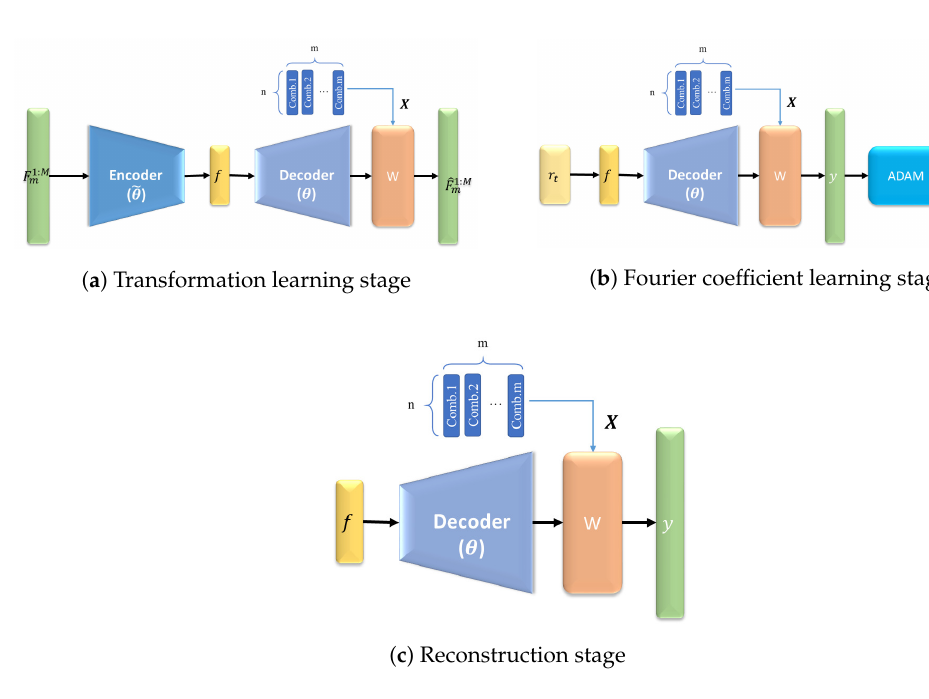
Figure 2. The illustration of the deep neural networks for submodular functions. ( a ) Transformation learning stage: In this stage, the goal is to train the decoder networks through input signal ( F 1: M m ) . The input signal F 1: M m is compressed as the Fourier coefficients ( f ) by encoder networks. Then, the f is decompressed by decoder networks. The decompressed f and combinational inputs generate the estimated signal ( ˆ F 1: M m ) . ( b ) Fourier coefficient learning stage: In this stage, the goal is to train the Fourier coefficients ( f ). The Fourier coefficients ( r t ) at time t are decompressed by the decoder networks. The decompressed f and combinational inputs generate the estimated signal y . Then, the y is computed through ADAM to get the Fourier coefficients ( r t + 1 ) at time t+1 . ( c ) Reconstruction stage: In this stage, the goal is to predict submodular functions according to f and combinational